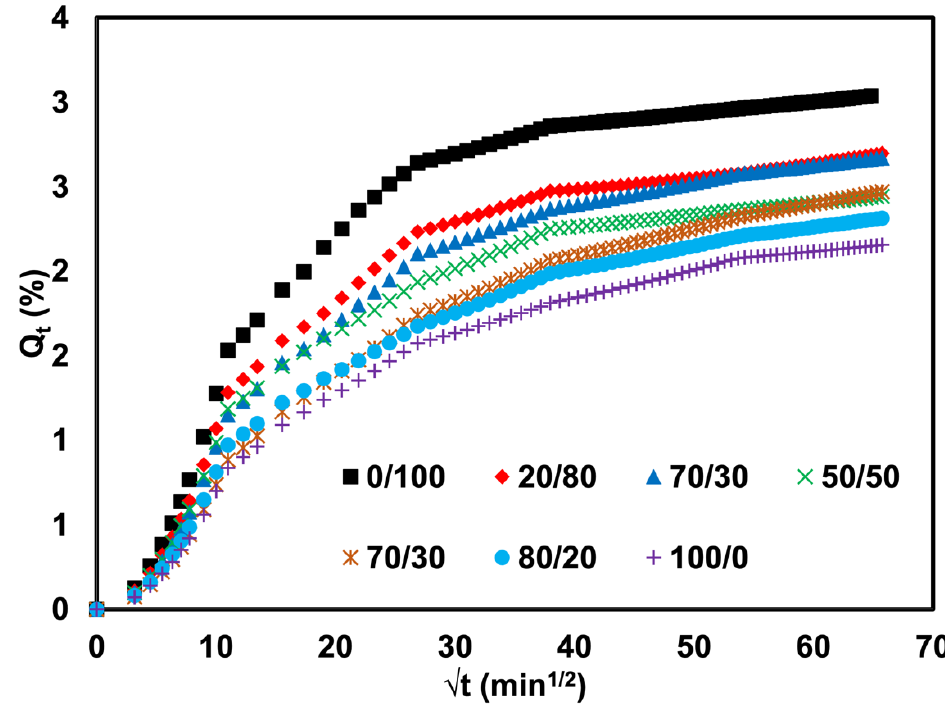
Figure 8. Mole percent uptake as a function of time of SR/NR blends.